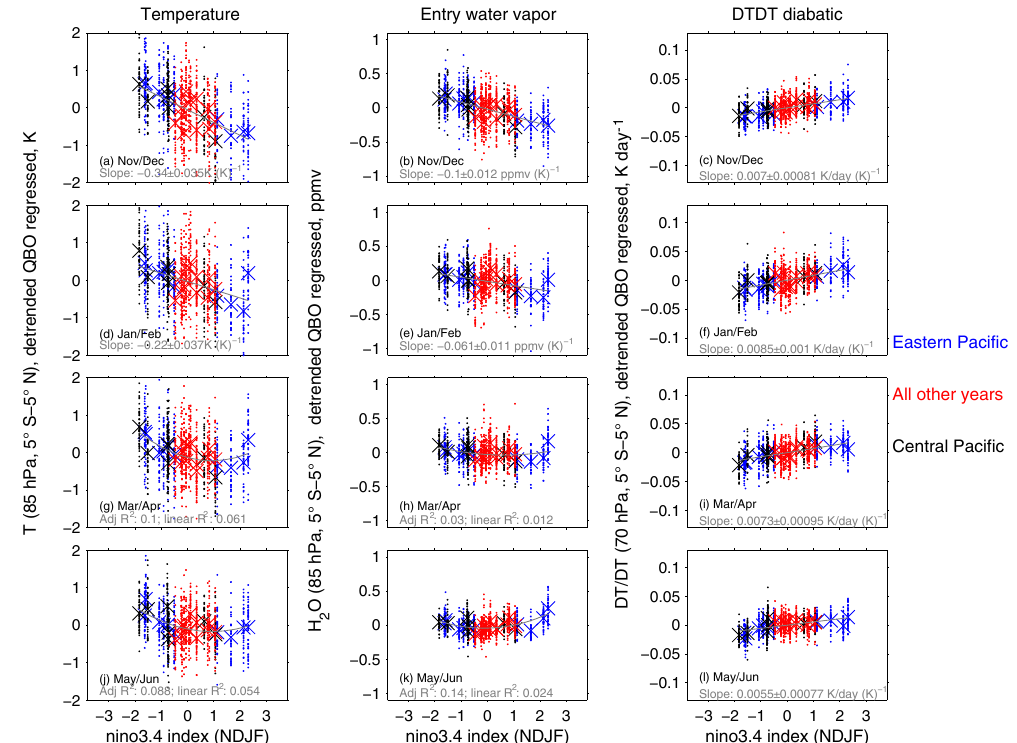
Figure 3. As in Fig. 2 but for 42 AGCM GEOSCCM integrations. The ensemble mean response is indicated with a large x, and each ensemble member with a